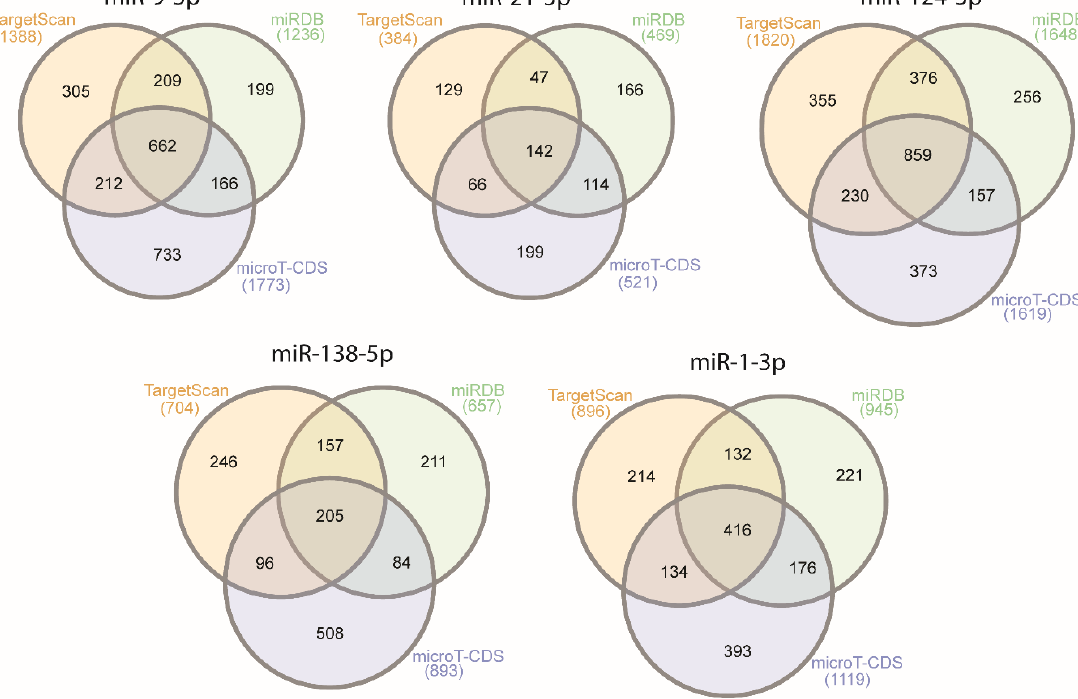
Figure 1. Venn diagrams of number of candidate miRNA target genes obtained from the TargetScan, miRDB, and microT-CDS datasets.